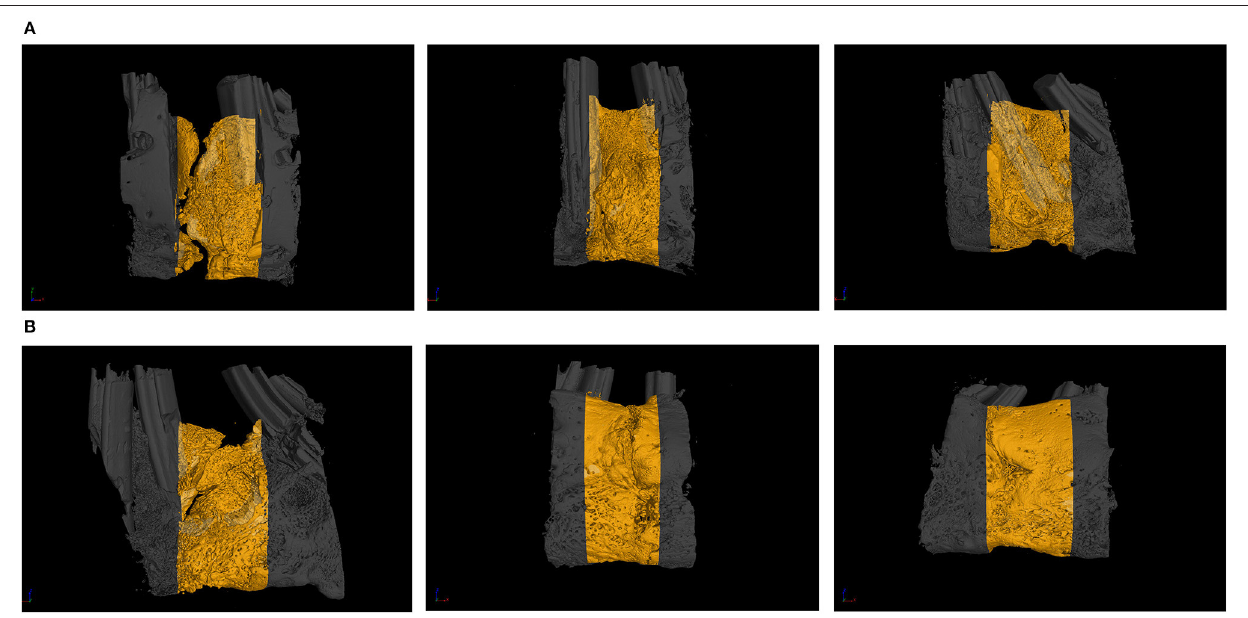
FIGURE 5 | (A) The Micro-CT (micro-computed tomography) from the blank control (group A), the green fluorescent protein (GFP) (group B), and the bone morphogenetic protein 1 (BMP-1) (group C) at 3 weeks of fixation (the yellow indicates the ontogenetic region). (B) The Micro-CT (micro-computed tomography) from the blank control (group A), the green fluorescent protein (GFP) (group B), and the bone morphogenetic protein 1 (BMP-1) (group C) at 6 weeks of fixation (the yellow indicates the ontogenetic